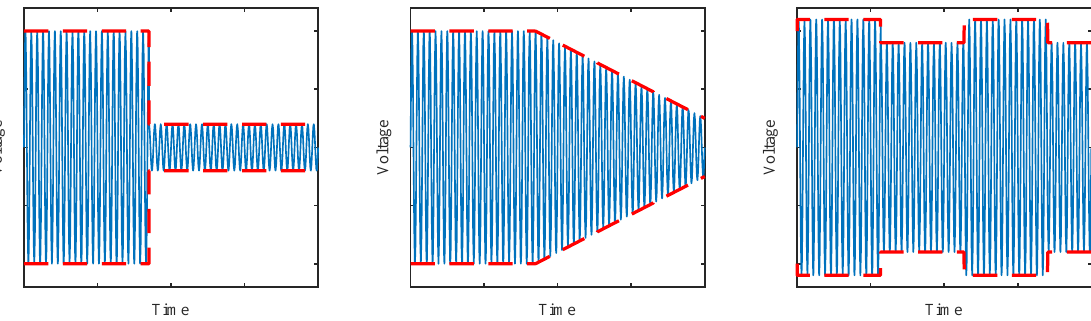
Figure 5. Schematic illustration of the employed modulation patterns. From left to right: constant modulation, linear modulation, and flicker-type